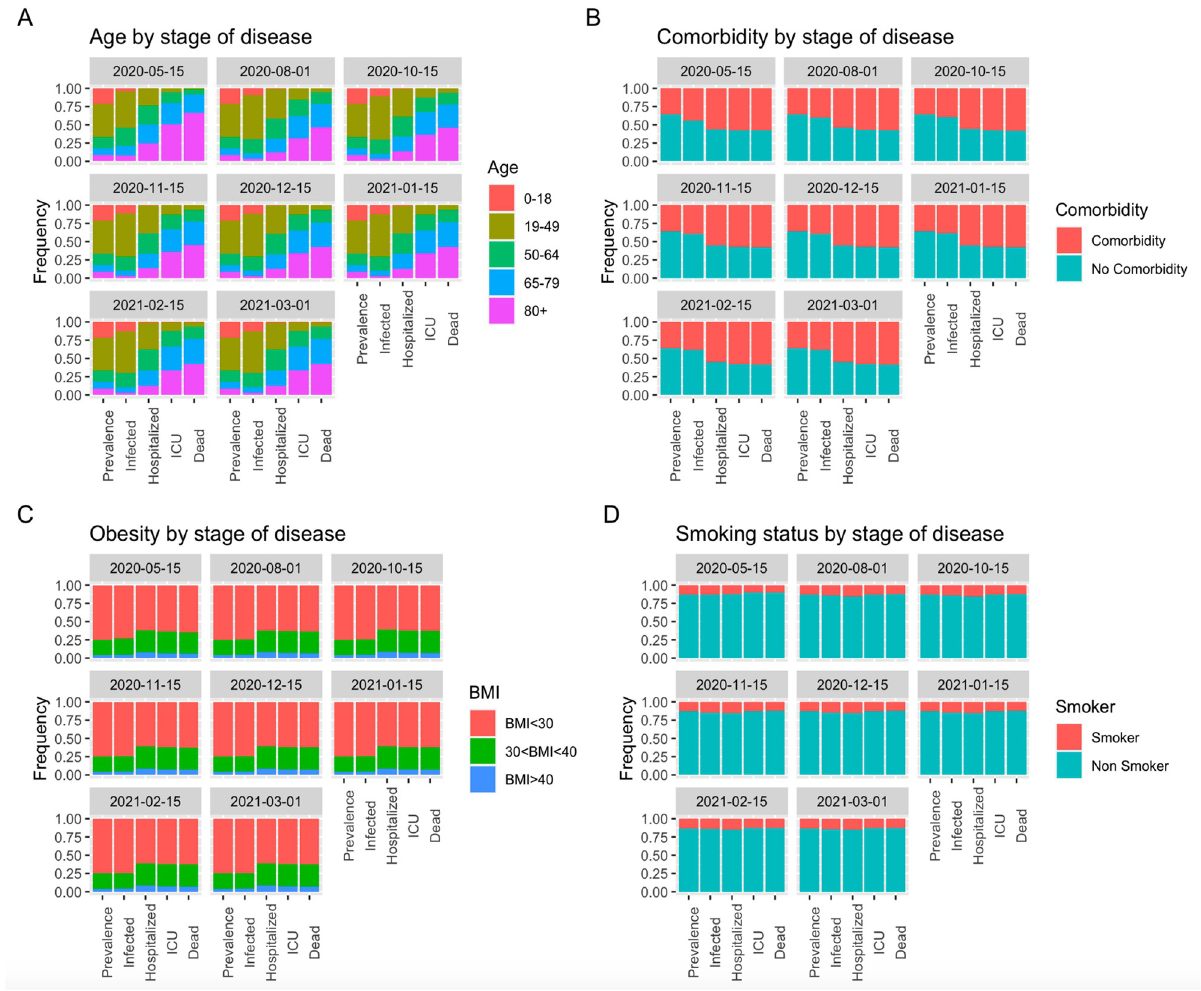
Fig 7. Estimated frequency of risk factor groups in the overall LAC population, and the distribution of individuals in each stage of disease from infected, hospitalized, admitted to ICU, to deceased at two week intervals from May 15, 2020 through March 1, 2021. (A) age group, (B) any comorbidity group, (C) obesity class group, and (D) smoking status